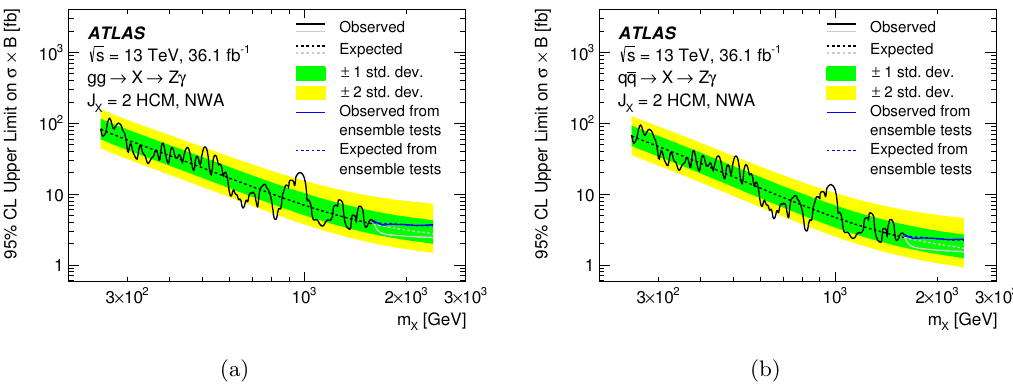
Figure 8 . The observed (solid line) and expected (dashed line) upper limit derived at the 95% CL p on (cid:27) ( pp ! X ) (cid:1) B ( X ! Z(cid:13) ) at s = 13 TeV as a function of the spin-2 resonance mass produced via (a) gluon-gluon initial states and (b) q (cid:22) q initial states modelled using the Higgs Characterisation Model (HCM), using the narrow width assumption (NWA). For m X > 1 : 6 TeV results are derived from ensemble tests in addition to the results obtained using closed-form asymptotic formulae. The shaded regions correspond to the (cid:6) 1 and (cid:6) 2 standard deviation bands for the expected exclusion limit derived using asymptotic